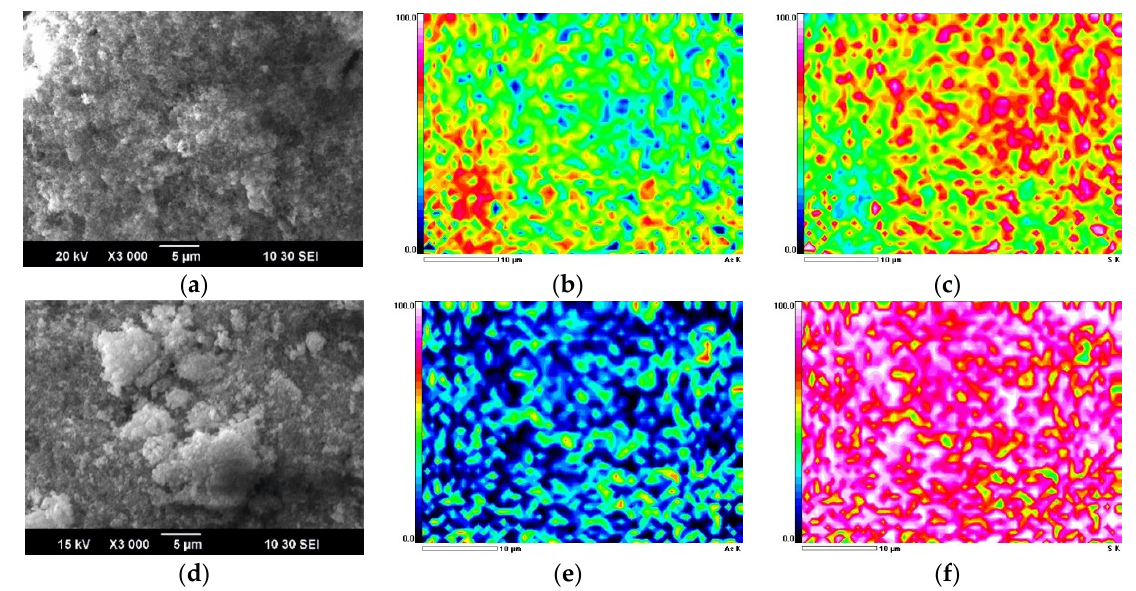
Figure 12. Micrographs of arsenic (III) sulphide precipitates with the introduction of As 2 S 3 at 34 g/L ( a ) and without its introduction ( d ); EDS mapping for arsenic ( b , e ) and sulphur ( c , f ).